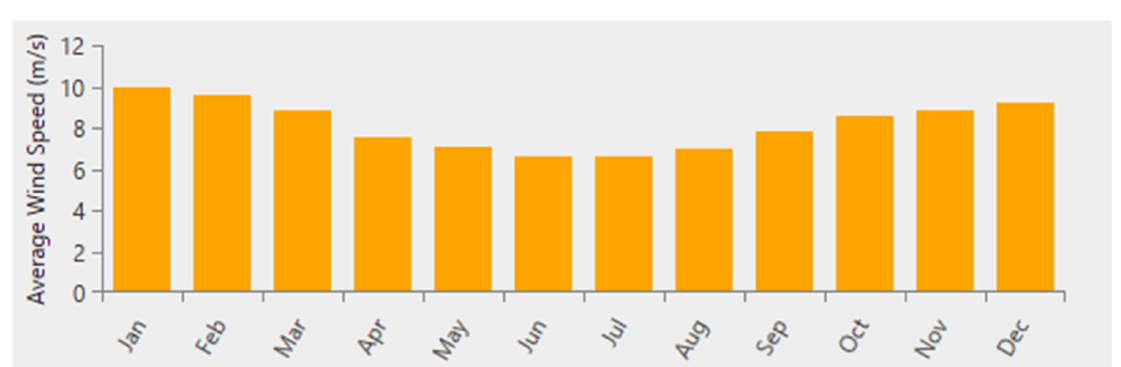
Figure 5. Monthly wind resource for Newcastle.